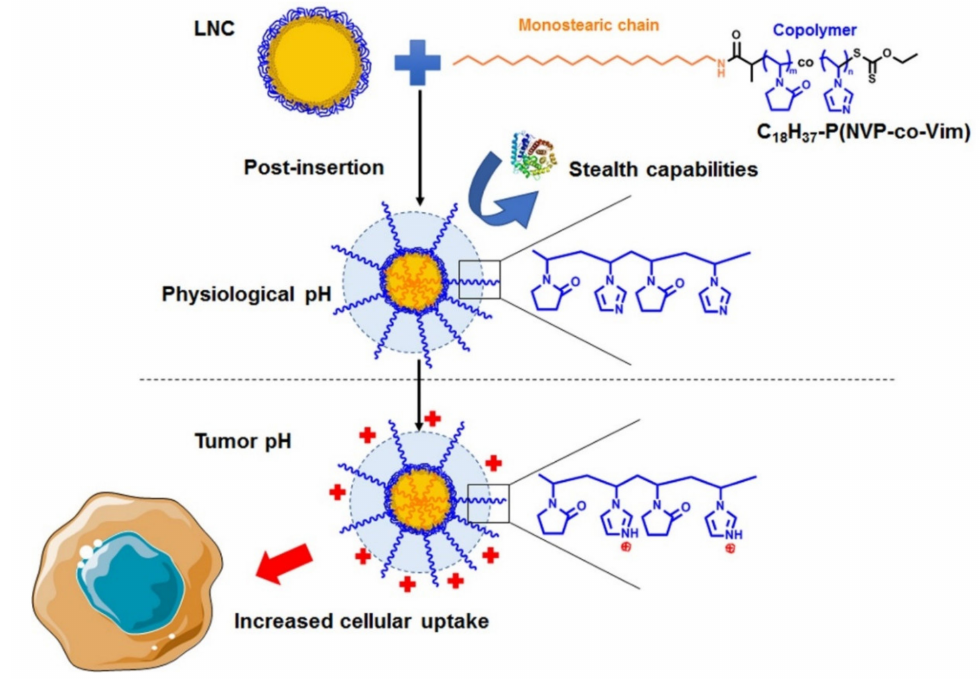
Figure 1. Decoration of LNC by C 18 H 37 -P(NVP-co-Vim)